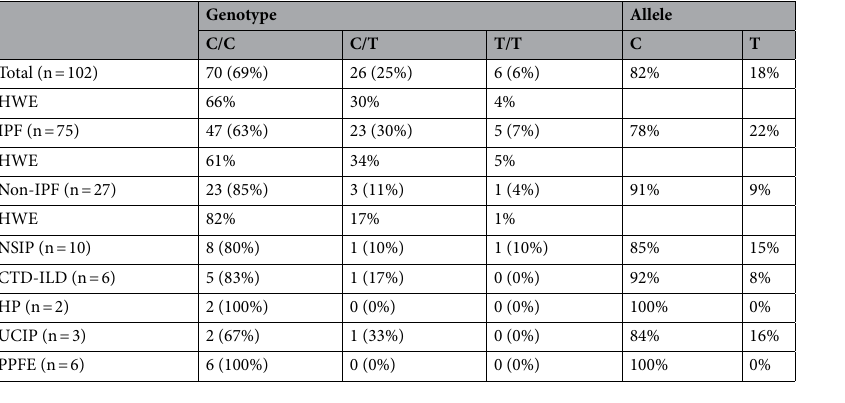
Table 2. Genetic and allele distribution of rs3750920. IPF idiopathic pulmonary fibrosis, NSIP non-specific interstitial pneumonia, CTD-ILD connective tissue disease-associated interstitial lung disease, HP fibrotic hypersensitivity pneumonitis, UCIP unclassifiable interstitial lung disease, PPFE pleuroparenchymal fibroelastosis, HWE expected frequency calculated by using the Hardy–Weinberg equilibrium.